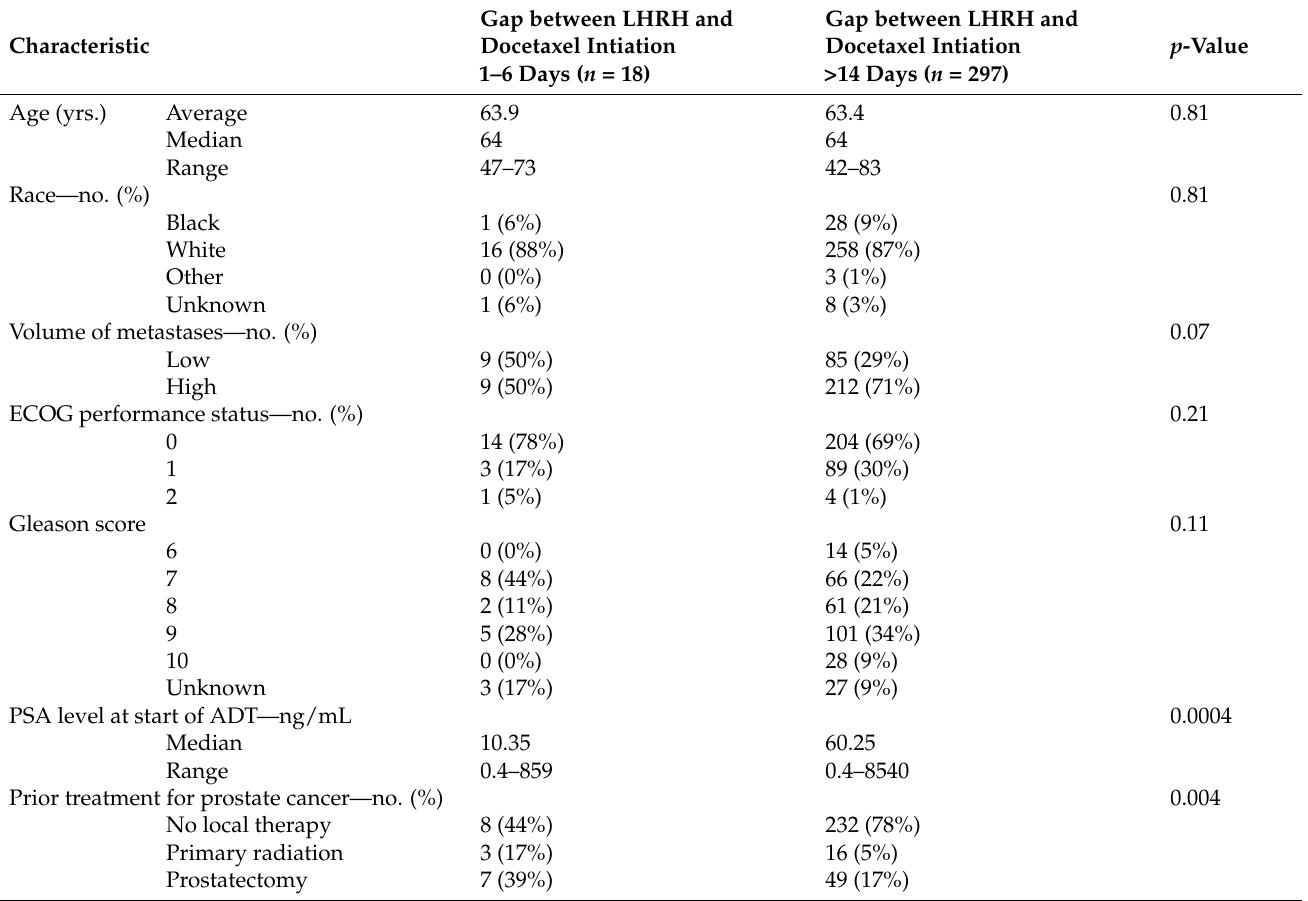
Table 1. Baseline Characteristics of the